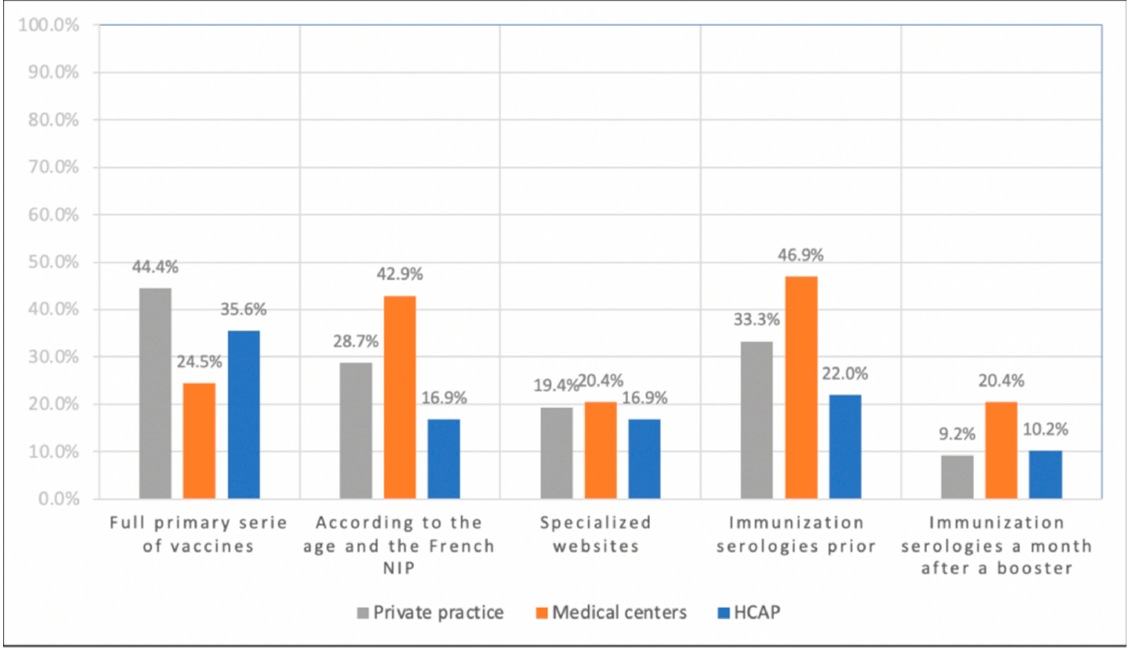
Figure 1. Vaccination strategy of 216 French general practitioners for an individual aged 2 and older without records of previous vaccinations (2017–2018).